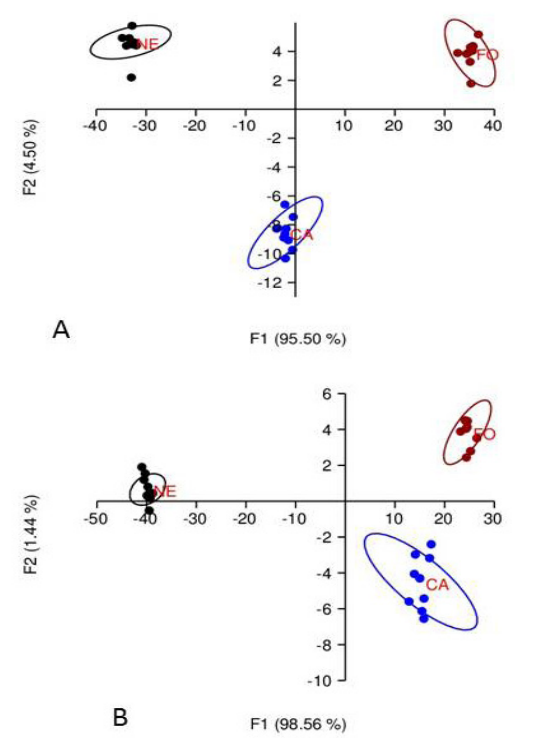
Fig 1 . Discriminant analysis graphs of chemical contents of cephalic salivary glands (A) and cuticle surface (B) of workers of Melipona quadrifasciata . All groups differed from each other. The individuals were 100% allocated correctly (F1+F2=100%). NE = newly emerged; CA = working in comb area; FO =